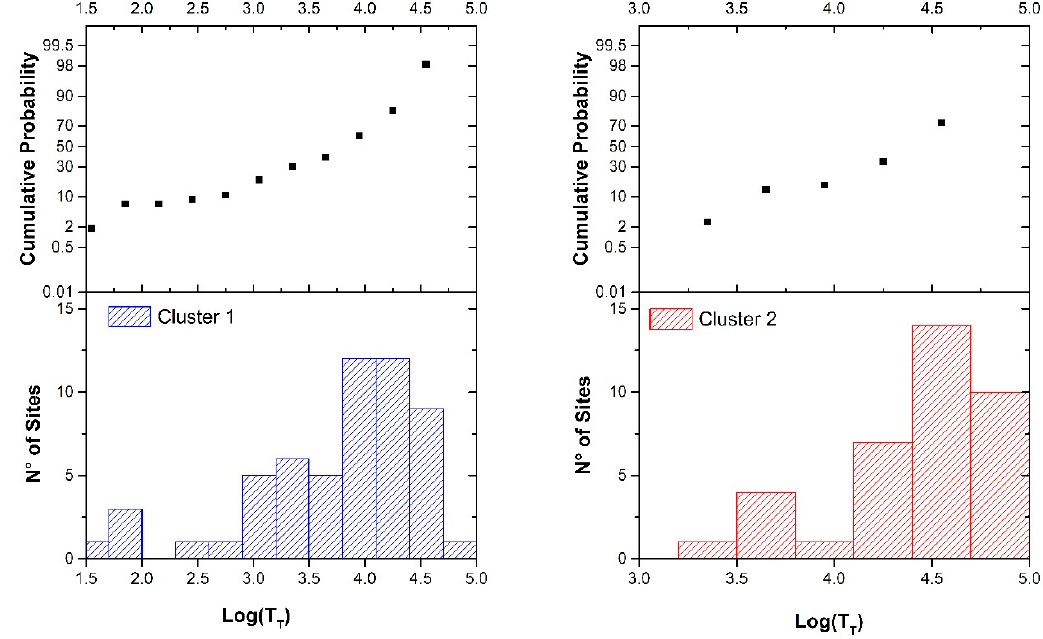
Figure 2. Number of sites and cumulative probability for Cluster 1 (left side) and Cluster 2 (right side) as a function of the non-acoustic parameter x = Log(T T ). Bin size is 0.3.